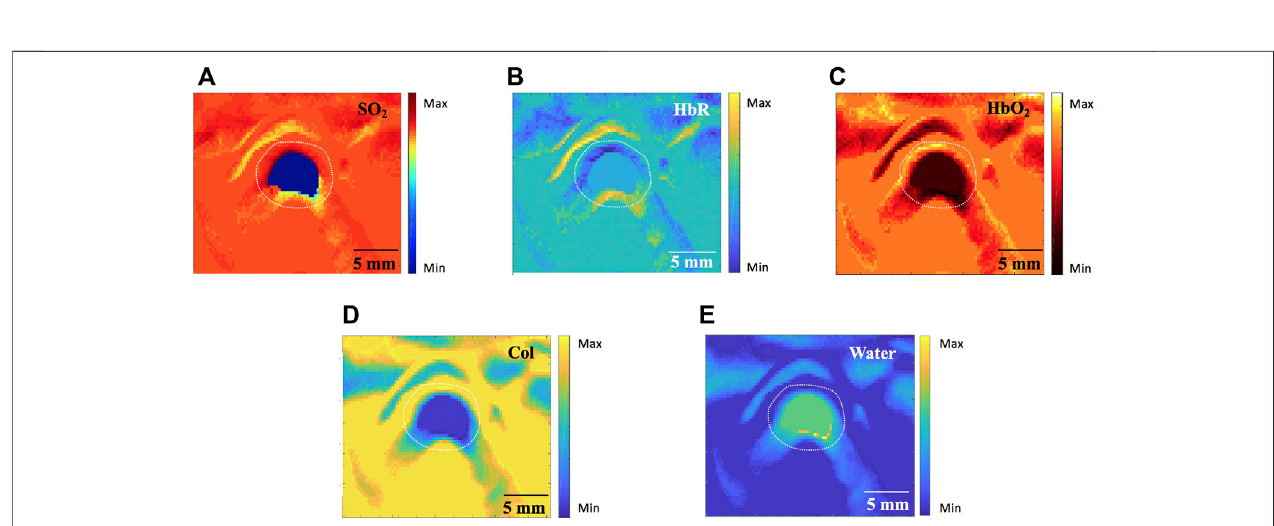
FIGURE6| TissuefunctionalparameterscalculatedbytheMSOTalgorithminGroupA(760nm,840nmand910 nmwavelength). (A) bloodoxygencontent(SO 2 ). (B) deoxygenated hemoglobin (HbR) (C) oxygenated hemoglobin (HbO 2 ). (D) Collagen (Col). (E) Water. MSOT, multispectral optoacoustic tomography. Scale bars are 5 mm